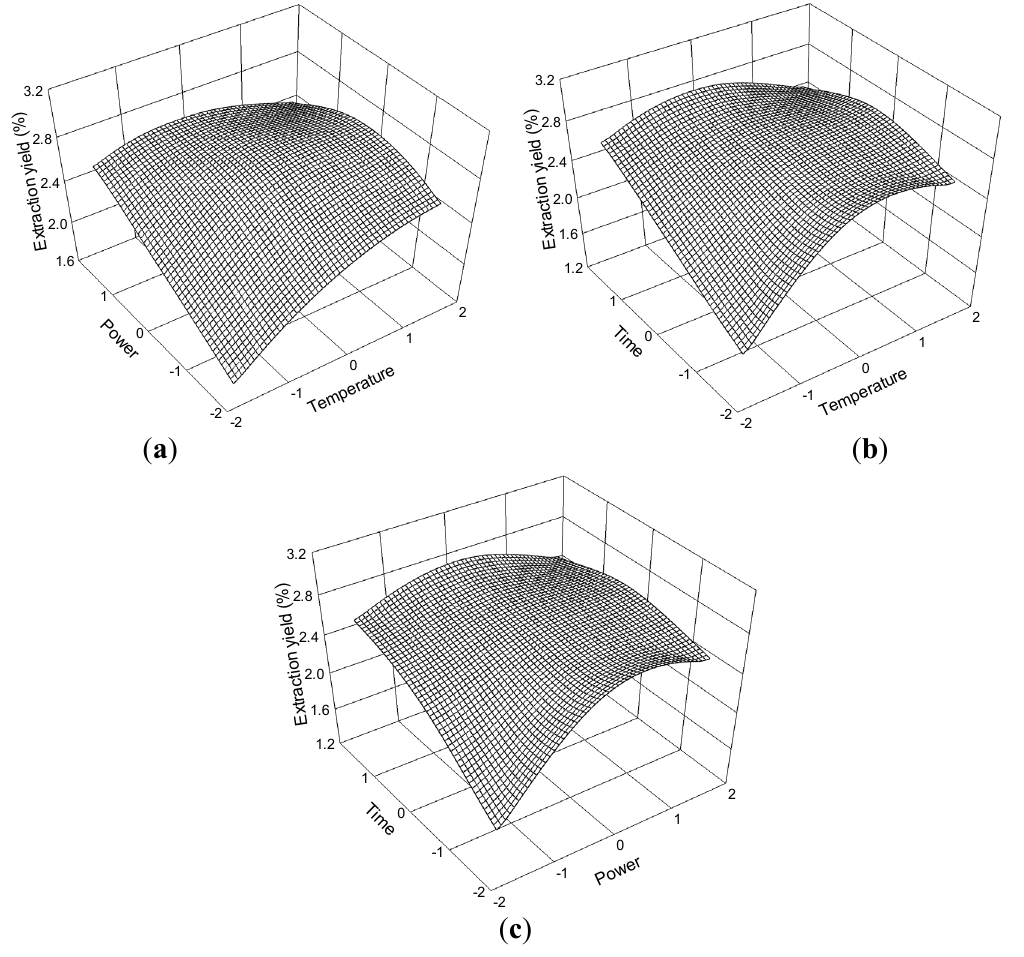
Figure 12. Response surface plots for the effects of ( a ) temperature/power ( b ) temperature/time ( c ) power/time on the extraction yield of